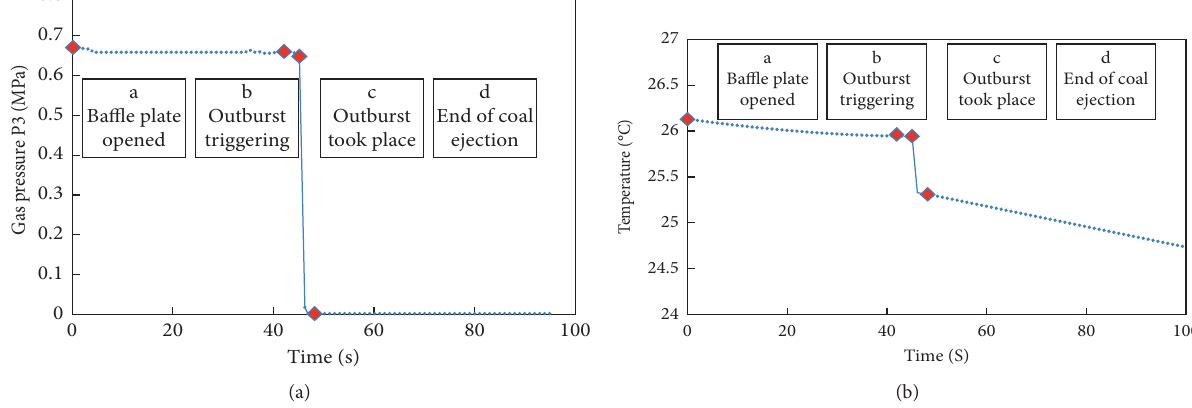
Figure 7: Gas pressure (a) and temperature (b) change curves during the delay outburst caused by geostress